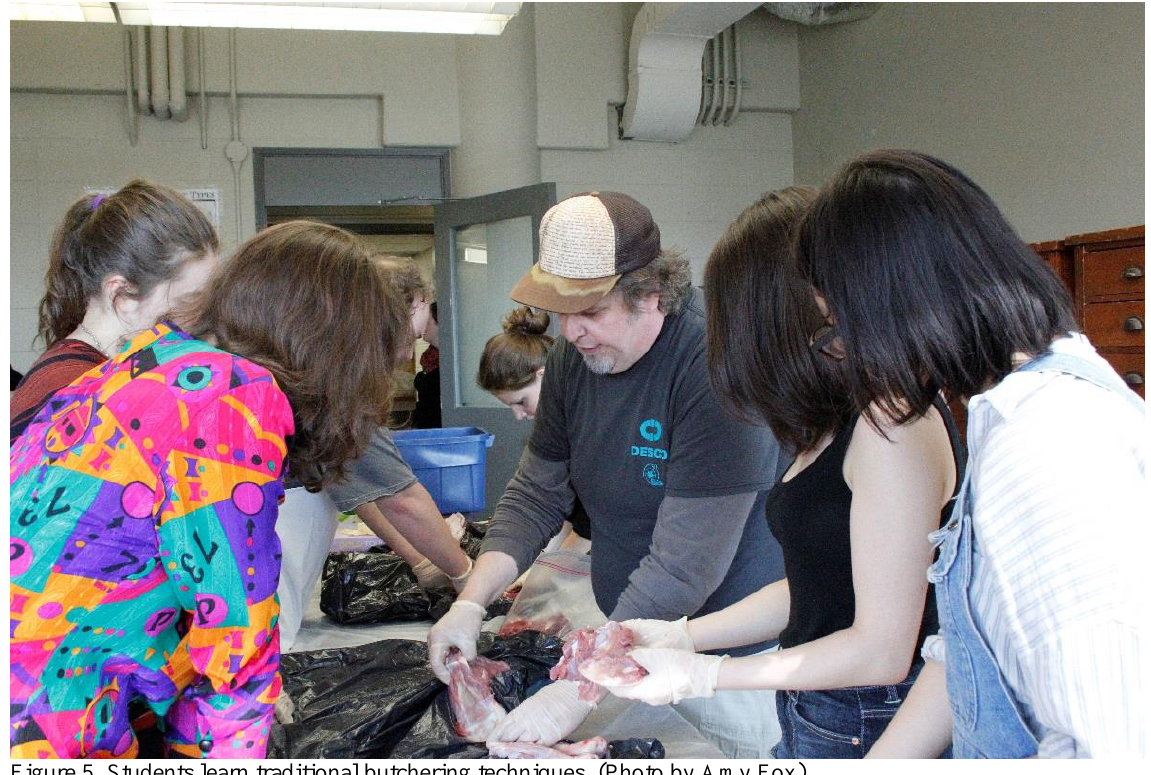
Figure 5. Students learn traditional butchering techniques. (Photo by Amy Fox)